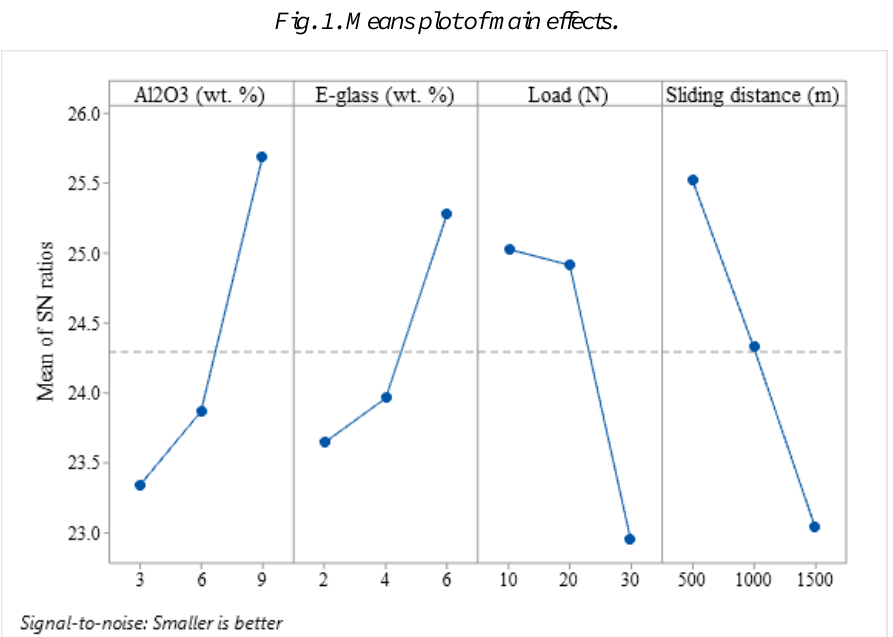
Fig. 2. S/N ratio plotted with main